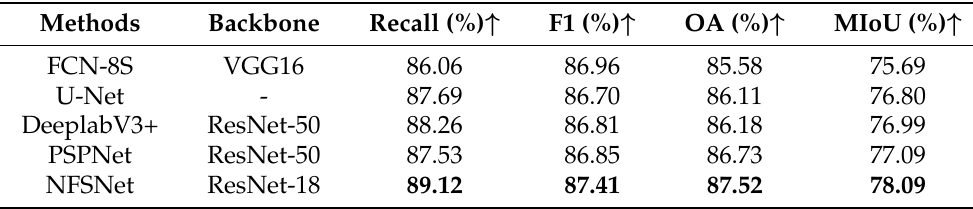
Table 3. Experimental results of Potsdam-B test set. The highest values for the different metrics are highlighted in bold, ↑ means the higher the better.